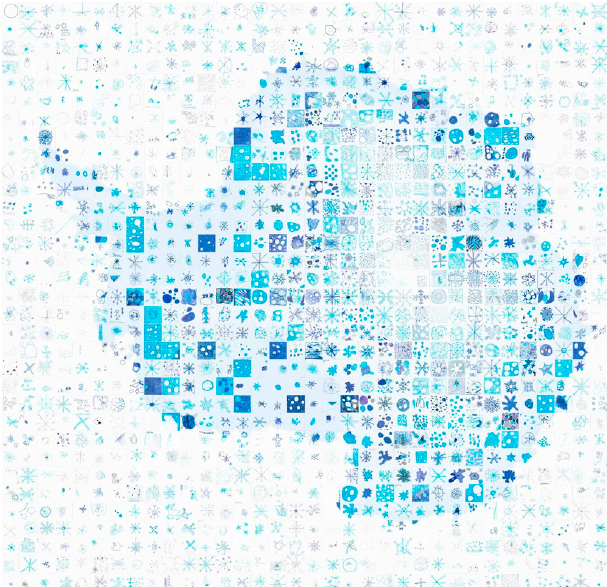
Figure 3. An example of a polar-themed mosaic, with the shape of Antarctica generated from image submissions. Image created by the author Heidi Roop in collaboration with Dan